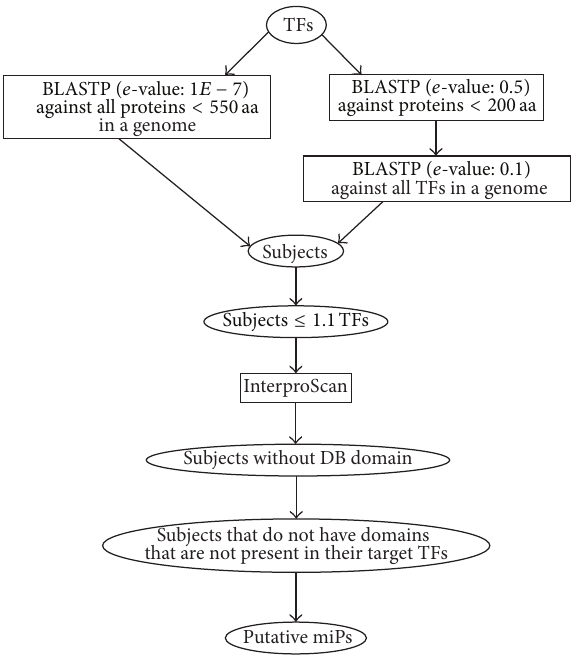
Figure 1: Diagram of miP3 showing all BLAST searches and filters